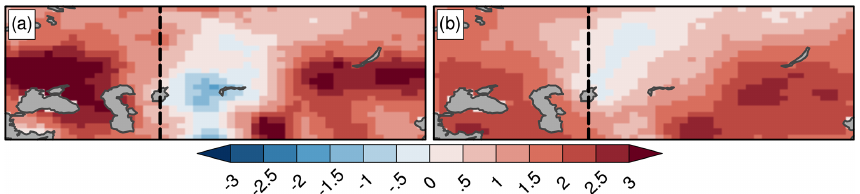
Figure C1. The 1979–2018 temperature trend patterns (units: ◦ C every 40 years) for western and central Asia based on the HadEX3 dataset: (a) TXx and (b) TNx. The black dashed line indicates the eastern boundary of the region map shown in Fig. 5.